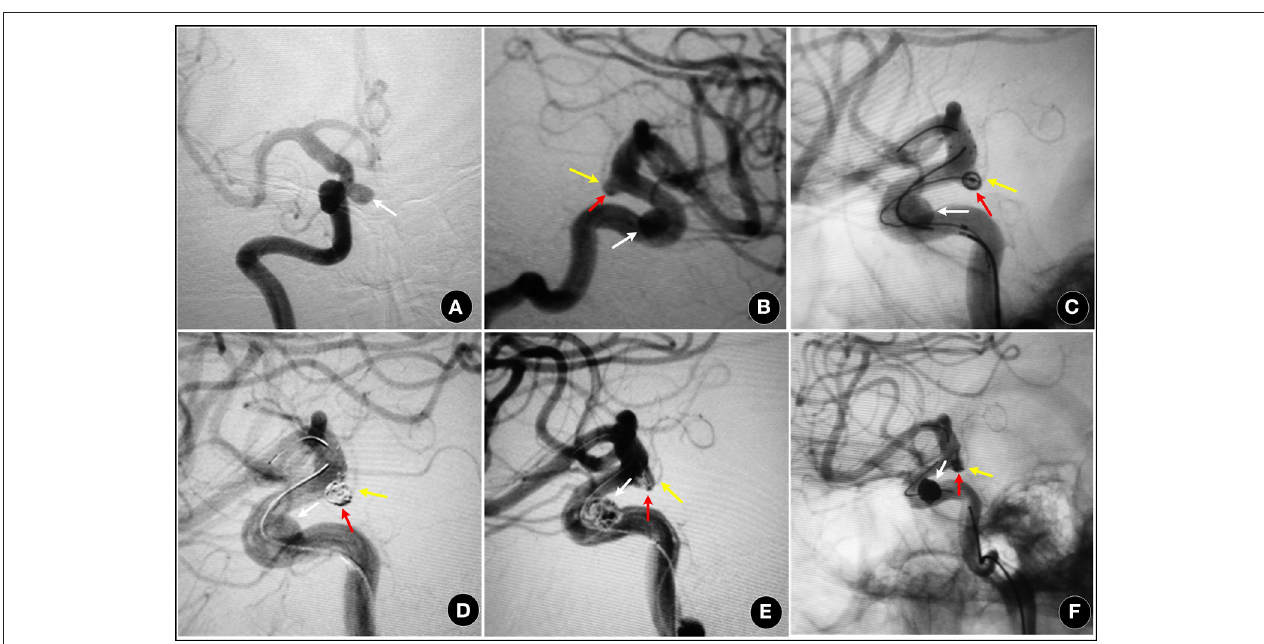
FIGURE 3 | A 55-year-old female, with an aneurysm found on routine examination. (A,B) showing a IIb type aneurysm (red arrow) and an ipsilateral ophthalmic artery aneurysm (white arrow). (C–F) two aneurysms were treated by SAC (Enterprise stent), and partially packed (RROC 3a). The AChoA was well-preserved (yellow arrow).